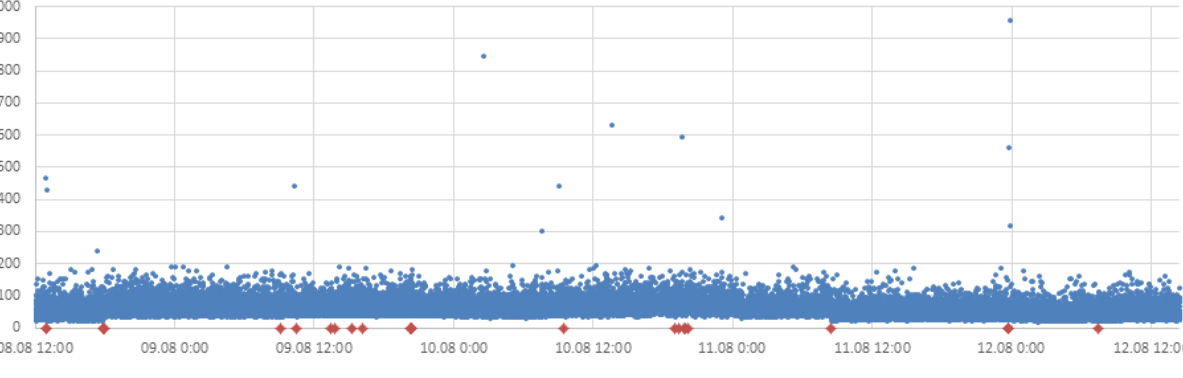
Fig. 8. RTT distribution in lightly loaded LMT 3G cellular network operator subsystem.